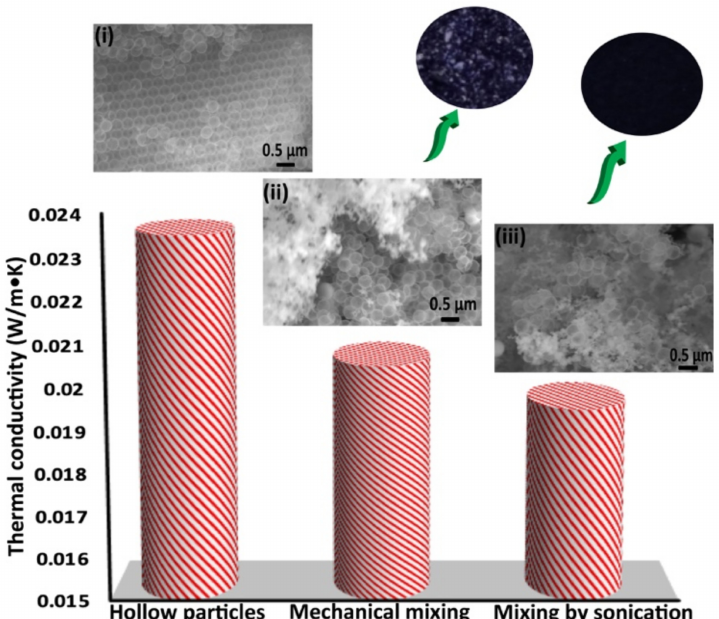
Figure 7. A plot showing the effect of CB dispersion on the thermal conductivity of a hollow particle– carbon black mixture. Insets (i), (ii), and (iii) are SEM images of hollow particles alone, a mechanically mixed hollow particle–CB mixture, and an ultrasonically mixed hollow particle–CB mixture, respectively. Sub-insets: Photos of mechanically and ultrasonically mixed CB and hollow